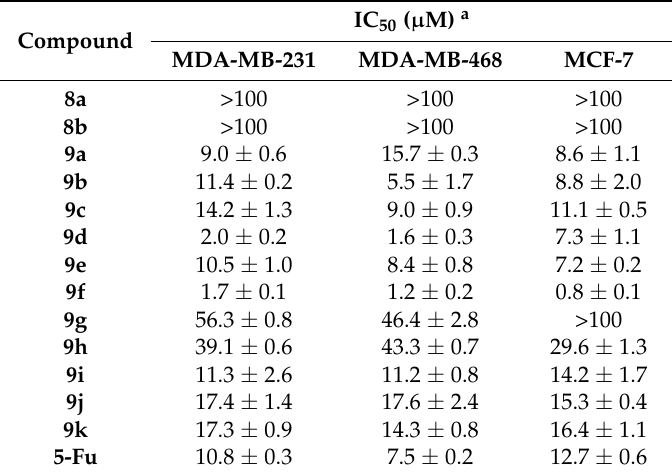
Table 1. Antiproliferative results of phenothiazine-1,2,3-triazole hybrids 9a – 9k